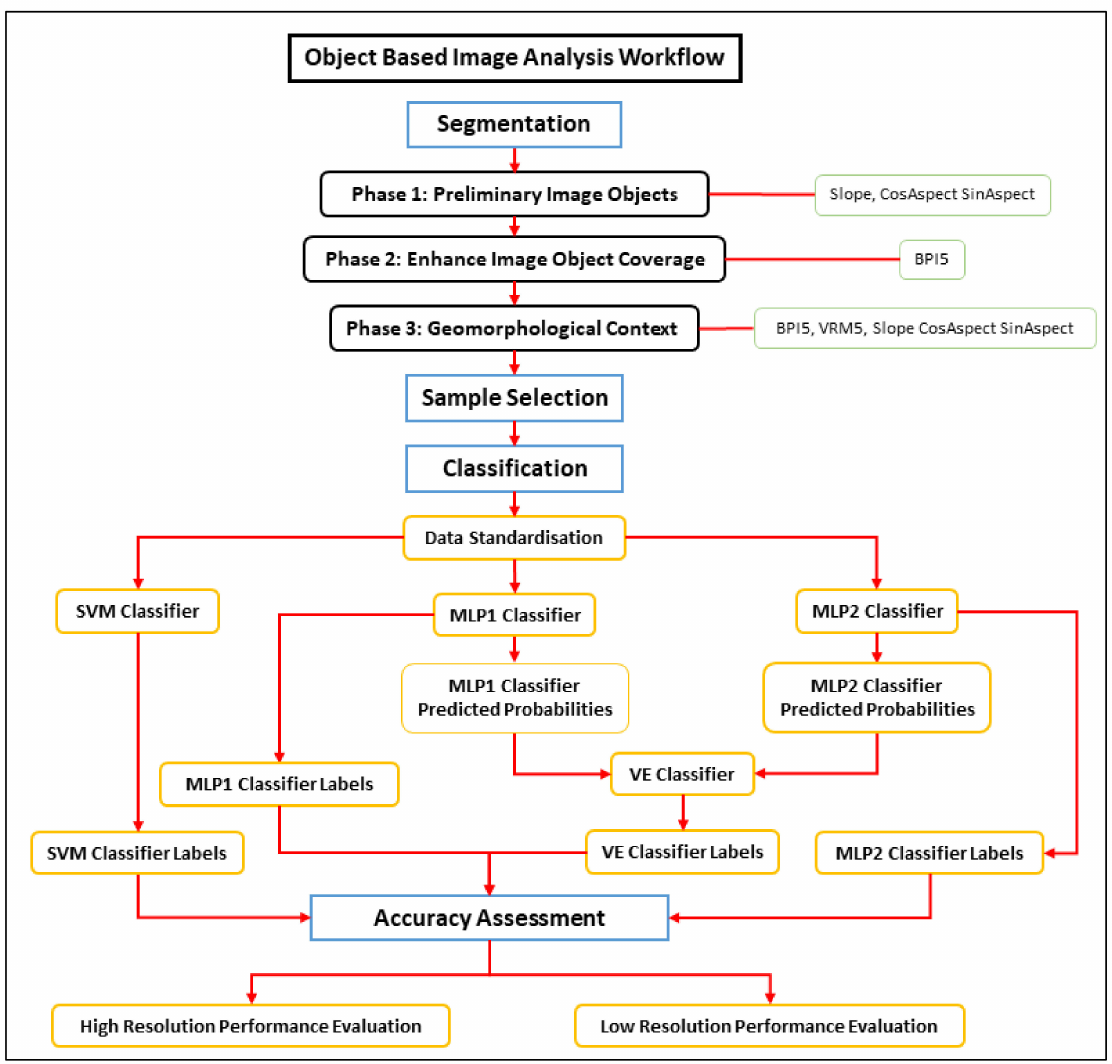
Figure 2. Workflow chart for the object-based image analysis (OBIA), with the image layers used in each phase of segmentation outlined in